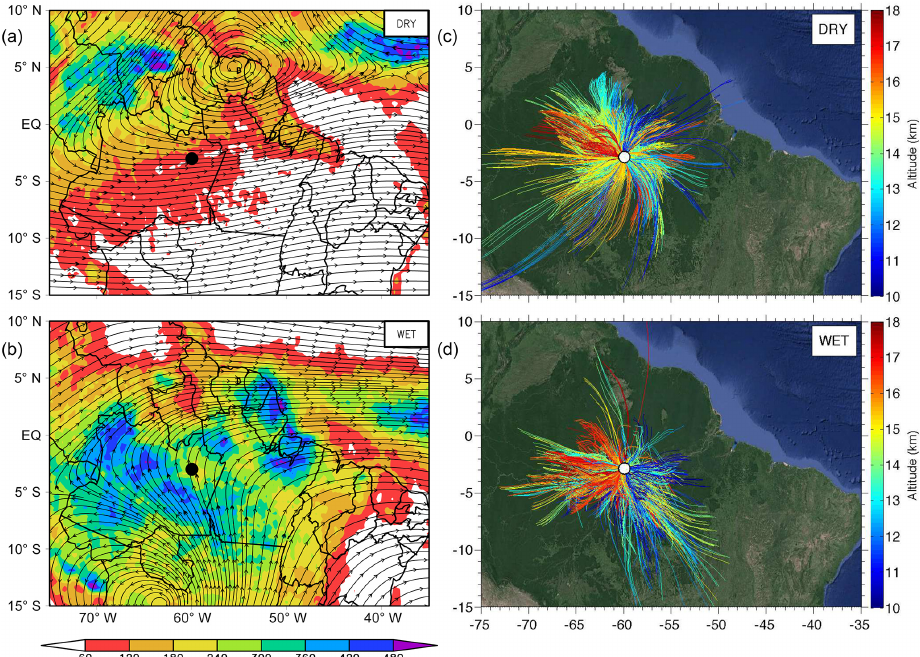
Figure 3. Panels (a, b) show mean precipitation (colors, mmmonth − 1 ) from the TRMM 3B42 version 7 and mean wind field (vectors, ms − 1 ) at 150hPa ( ∼ 14.3km) from ECMWF ERA-Interim reanalysis. Panels (c, d) show 24h backtrajectories of air masses arriving at the site at the time and altitude that cirrus layers were detected. Results are shown separately for the dry (JJAS, a, c ) and wet months (JFMA, b, d ). Backward trajectories were computed using HYSPLIT model with 0.5 ◦ resolution winds from GDAS/NOAA. The experimental site location is indicated in all panels with a